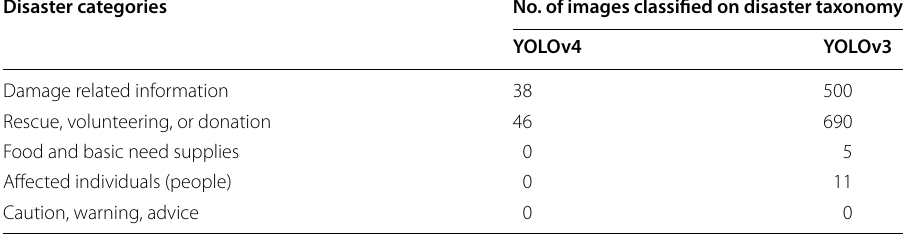
Table 10 Comparison of YOLOv4 and YOLOv3 classification results on emergency response taxonomy using only the custom dataset